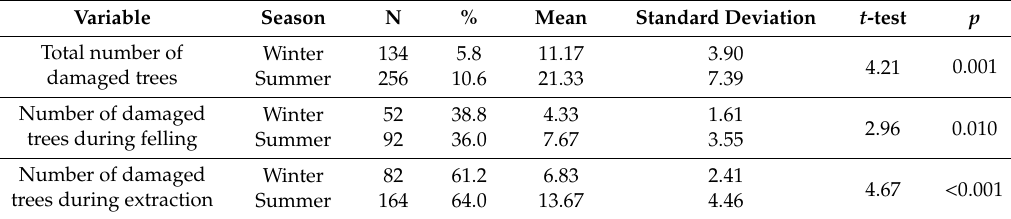
Table 1. Number of damaged trees.